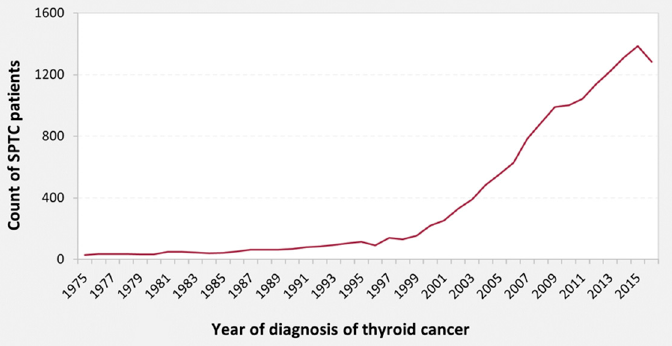
Figure 1. The annual increase in diagnosed cases of thyroid cancer. SPTC: Second primary thyroid cancer.